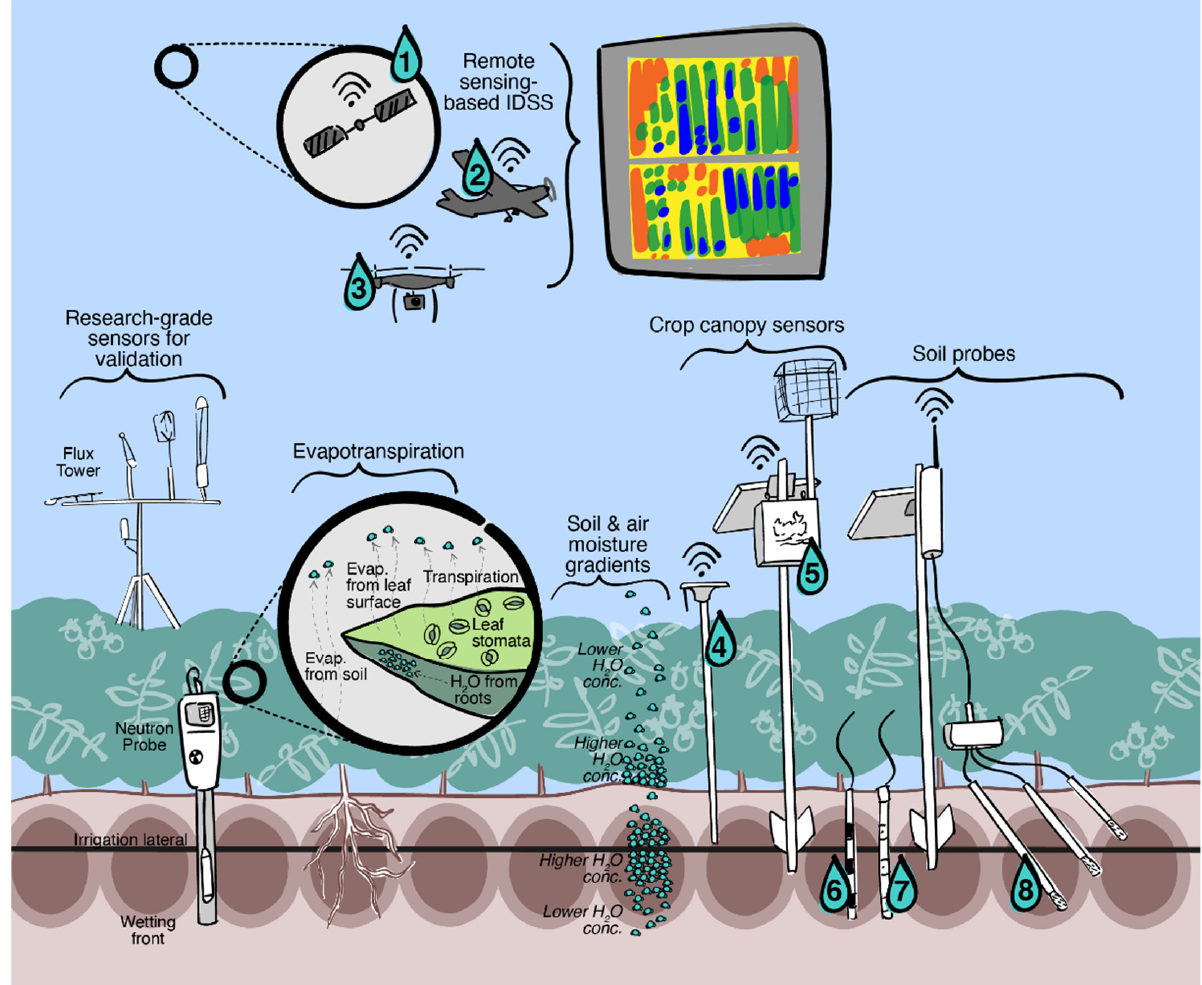
Figure 2. Conceptual illustration of integration and application of imagery (IDSS 1 is satellite im- agery, 2 is aerial reflectance, and 3 is drone imagery using multispectral/thermal cameras), canopy (IDSS 4 and 5 based on crop evapotranspiration and other canopy-based parameters) and soil-based IDSS (IDSS 6 and 7 based on volumetric water content and 8 based on soil water potential) in a processing tomato field. Eddy covariance tower and neutron moisture probes are useful to estimate a complete water balance for validation of these available IDSS measurements. Artwork by Dr. Bonnie McGill.